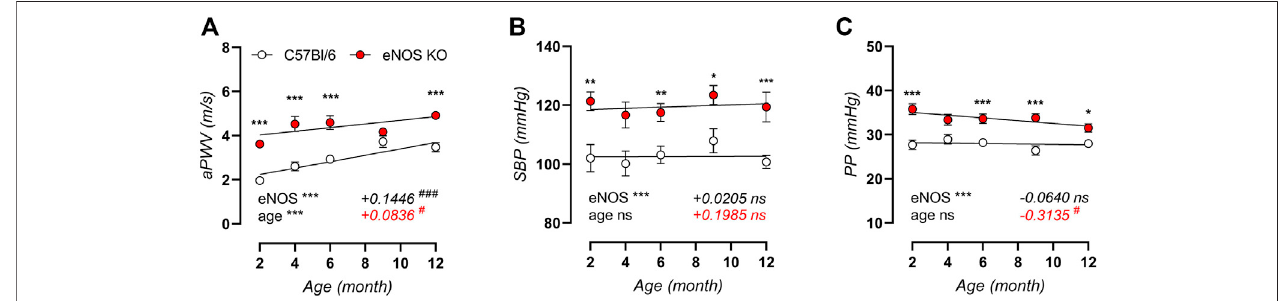
FIGURE 1 | In vivo arterial aging is less pronounced in eNOS knockout versus C57Bl/6 control mice. Measurements of aPWV (A) , systolic blood pressure (SBP, (B) ),andpulsepressure(PP, (C) )wereperformedinagingeNOSknockout( n > 10)andC57Bl/6control( n > 9)mice.Age-dependentchangeswereanalyzedusinglinear regression (slope displayed, bottom right). An F-test was used to assess if the slope was different from zero. Statistical analysis using two-way ANOVA. Overall signi fi cance(bottomleft)andpost-hocsigni fi cance(ingraph)arelisted.ANOVA:ns, p > 0.05;*, p < 0.05;**, p < 0.01;***, p < 0.001.F-test:ns, p > 0.05;#, p < 0.05; ###, p <